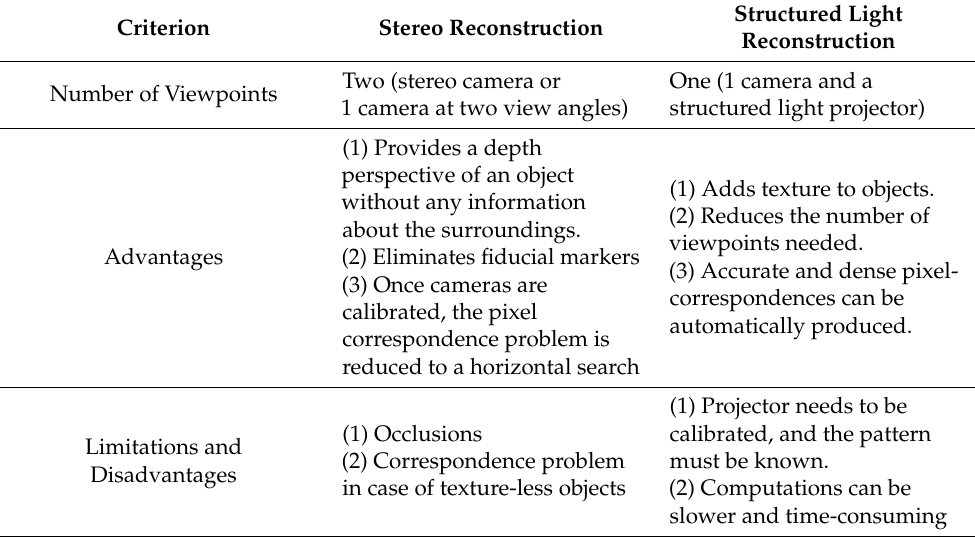
Table 1. Comparison between stereo and structured light reconstruction